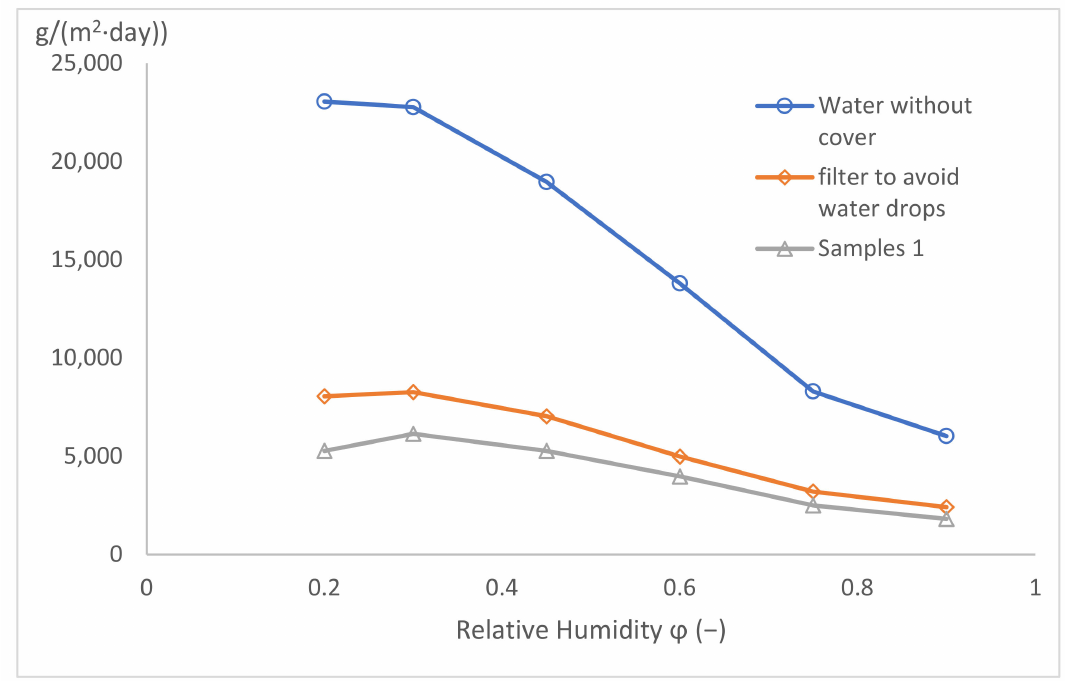
Figure 13. Water vapour permeability for different samples.